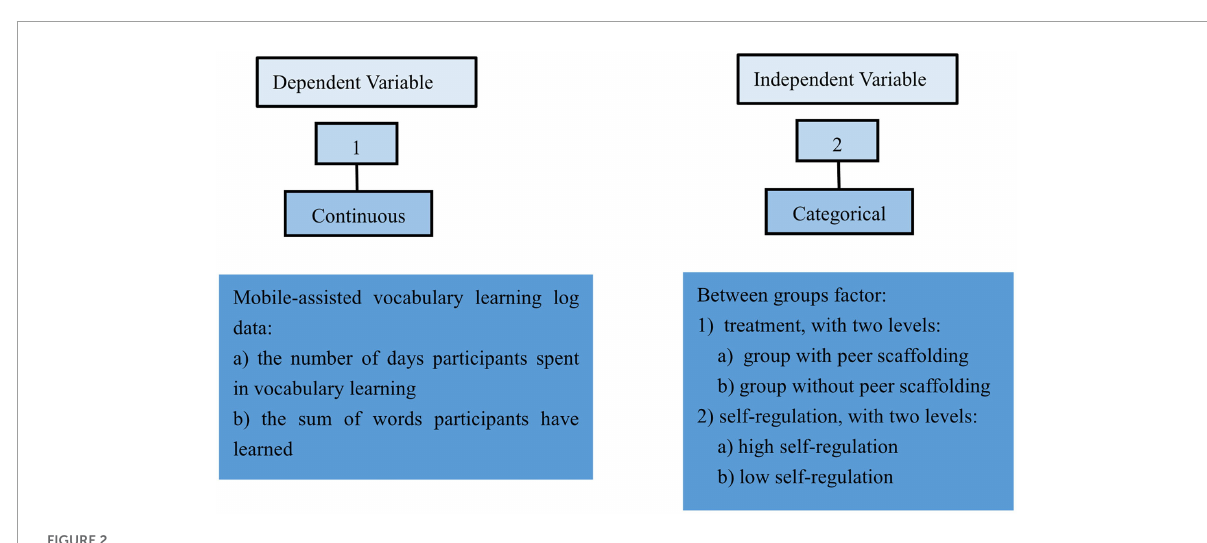
FIGURE1 Research procedure of the experiment.